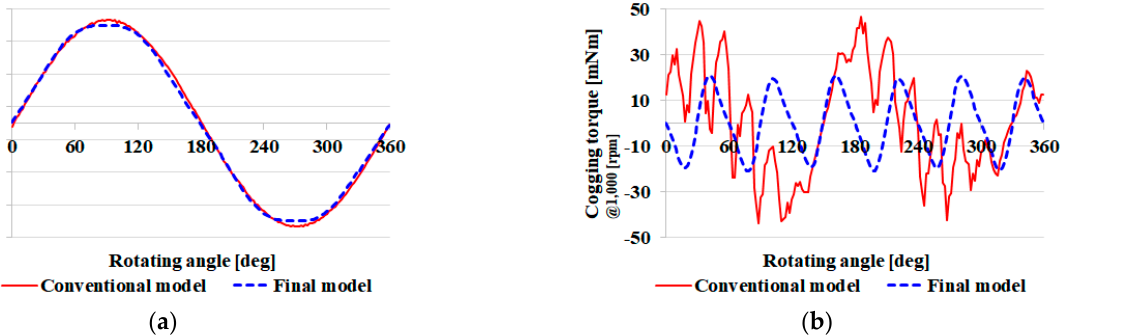
Figure 11. Waveform comparison of the conventional model and the final model: ( a ) back EMF, ( b ) cogging torque.